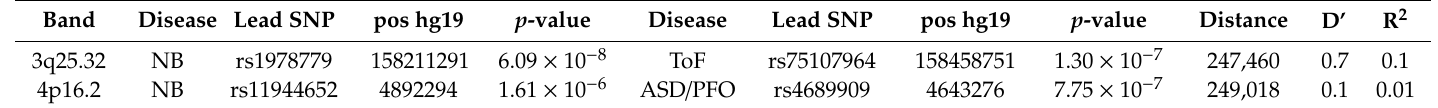
Table 4. Physical distance between lead SNPs in NB and the diverse CHD subtypes.